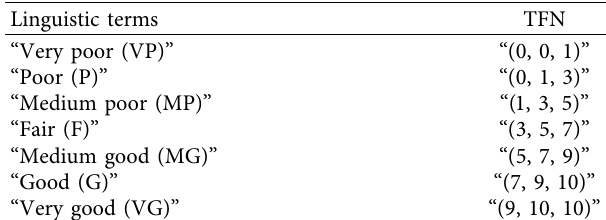
Table 2: Scale for of alternative evaluations in HF- MULTIMOORA. Linguistic